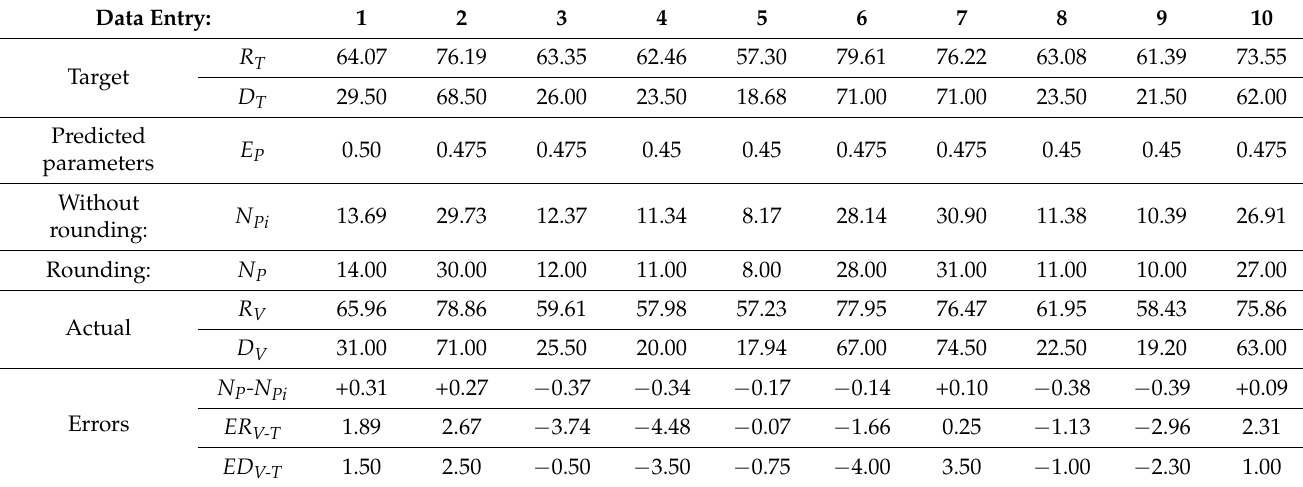
Table 6. Errors when rounding to produce the number of shots